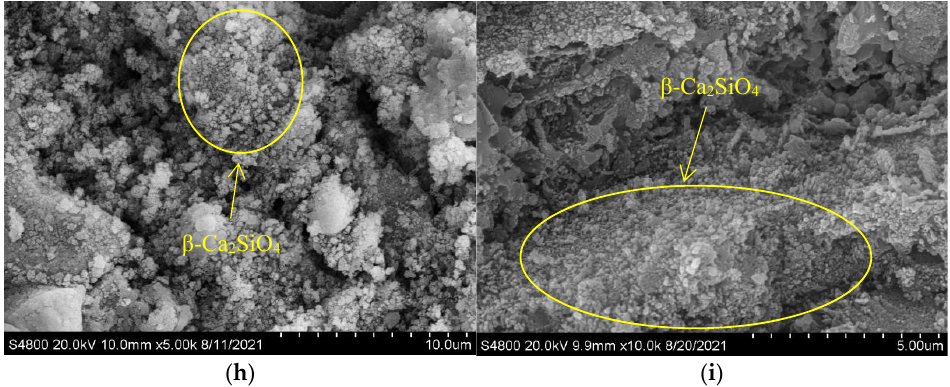
◦ C, ( b ) 0.30–0–200 ◦ C,